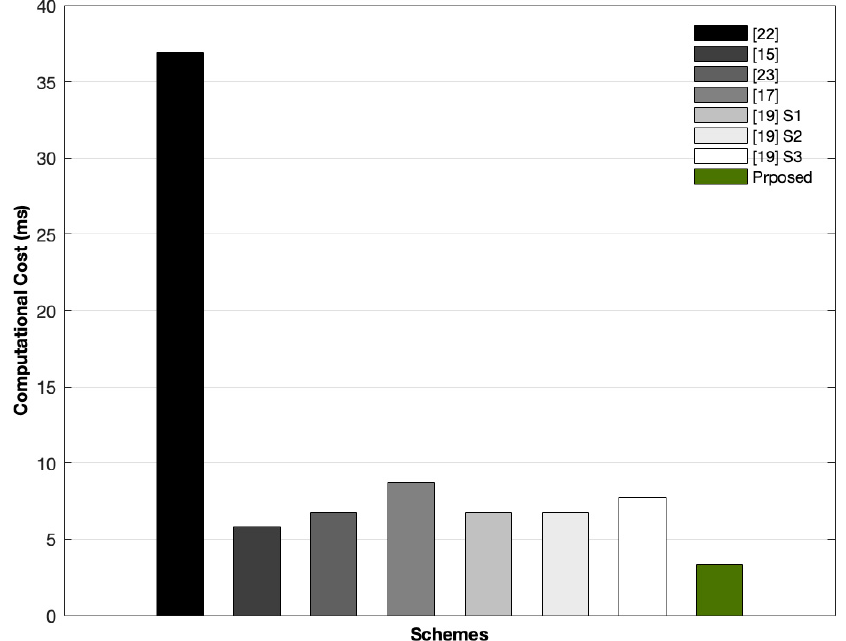
Figure 4. Total computational cost reduction.